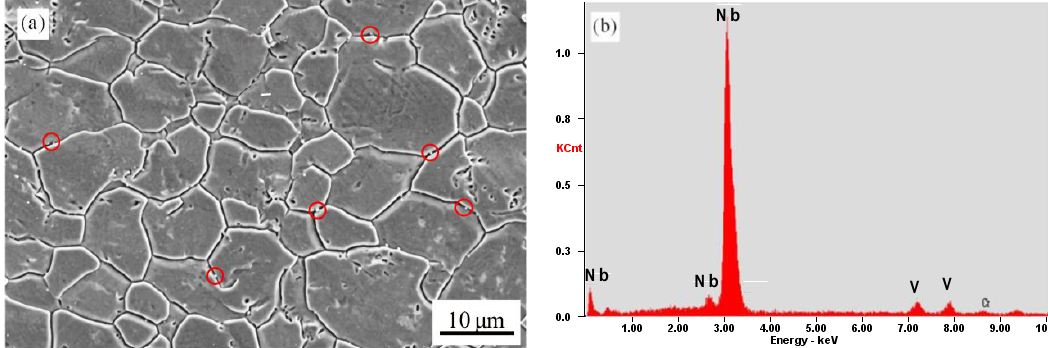
Figure 2. Microstructure of solution-treated experimental steel. ( a ) SEM of solution-treated experimental steel, the precipitates on the grain boundary are marked with red circles, ( b ) energy spectrum analysis of precipitates.